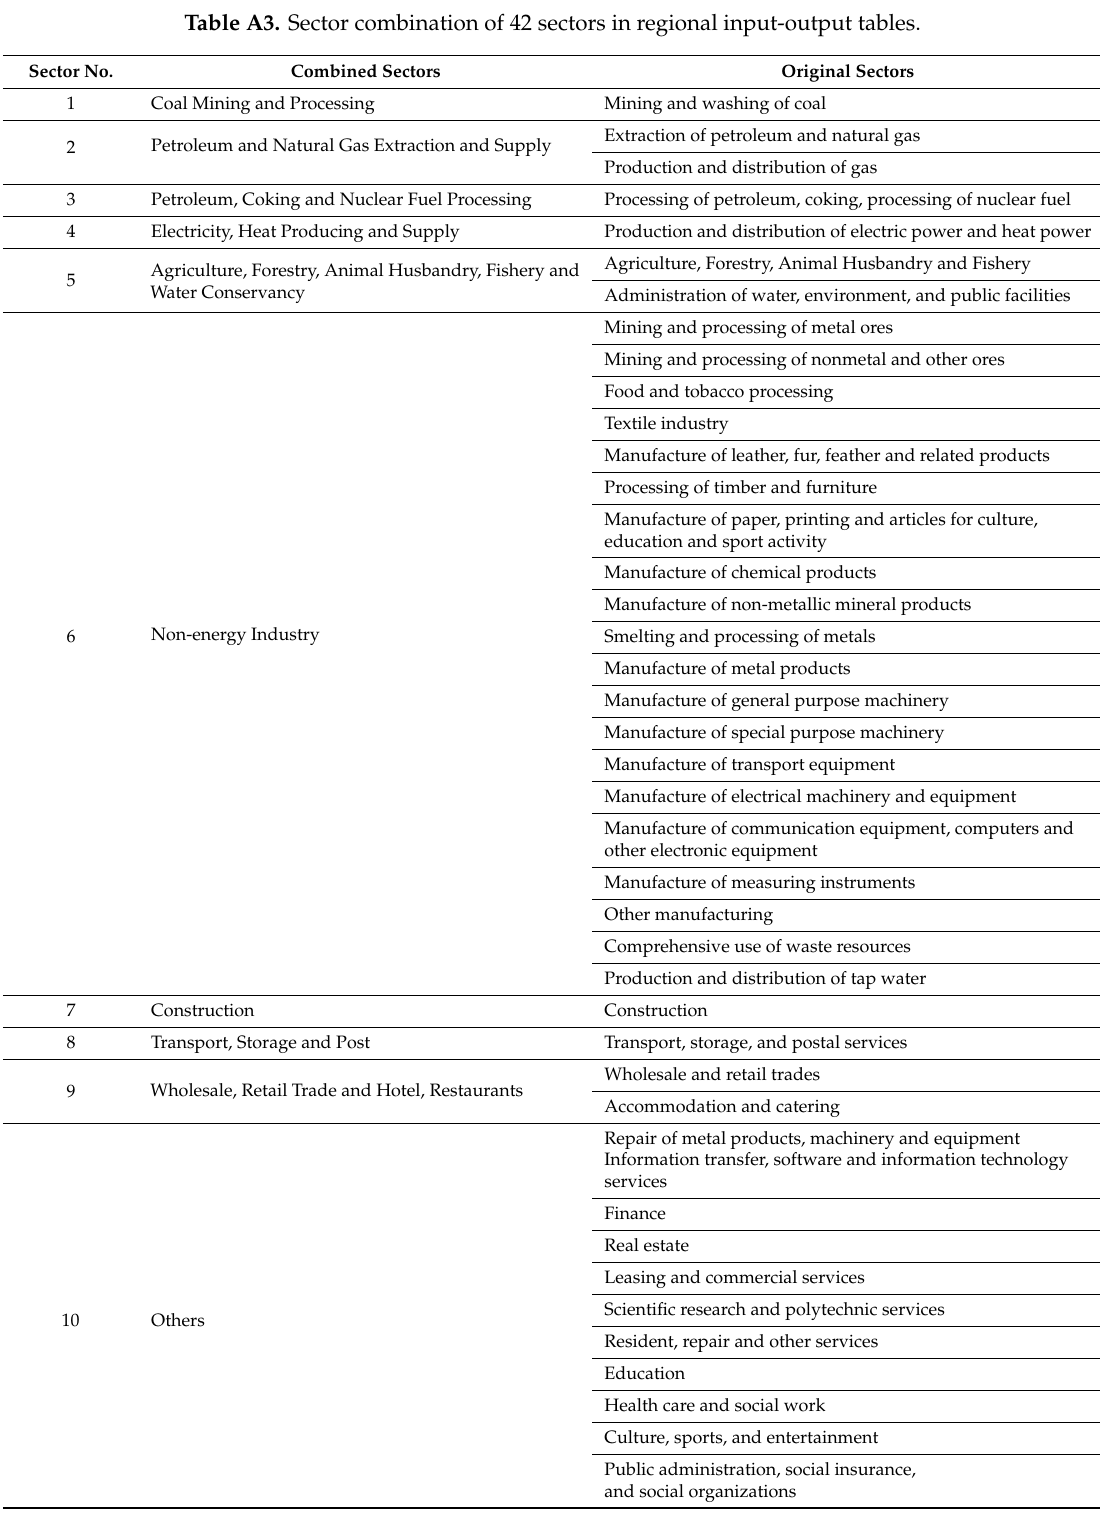
Table A3. Sector combination of 42 sectors in regional input-output tables. Sector